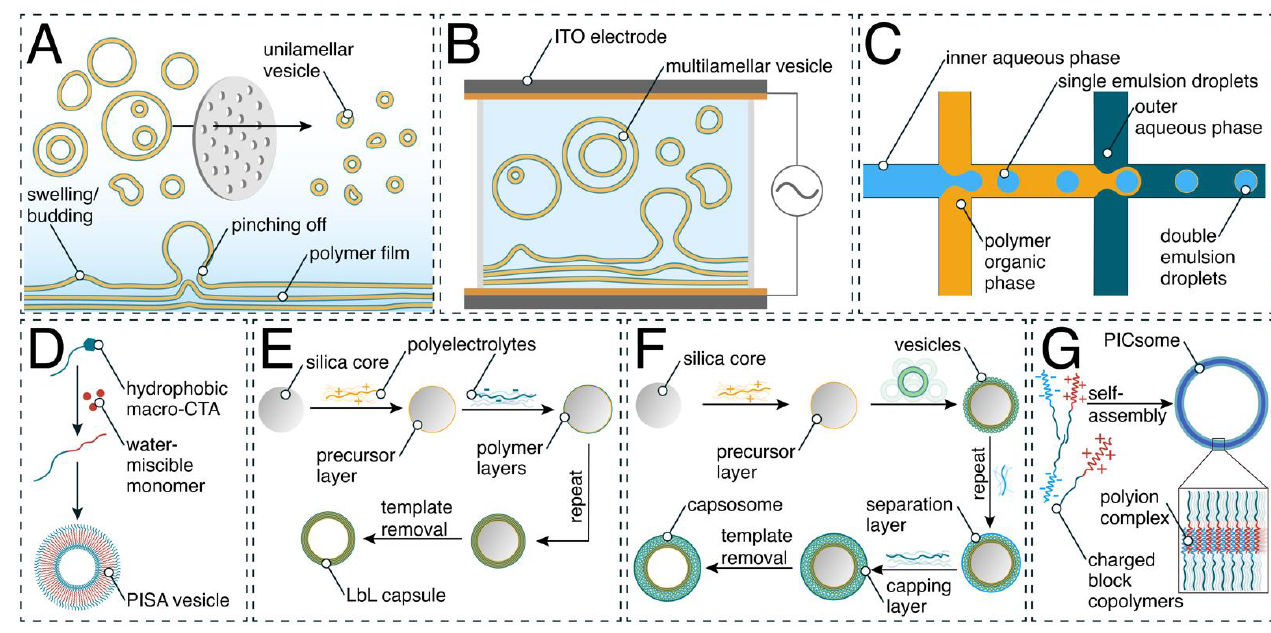
Scheme 1. Schematic representation of selected production methods of synthetic compartments: ( A ) film rehydration and subsequent extrusion of block copolymers; ( B ) electroformation; ( C ) double emulsion formation with a microfluidic setup; ( D ) polymerization-induced self-assembly (PISA); ( E ) layer-by-layer (LbL) assembly; ( F ) assembly of capsosomes; and ( G ) PICsomes.